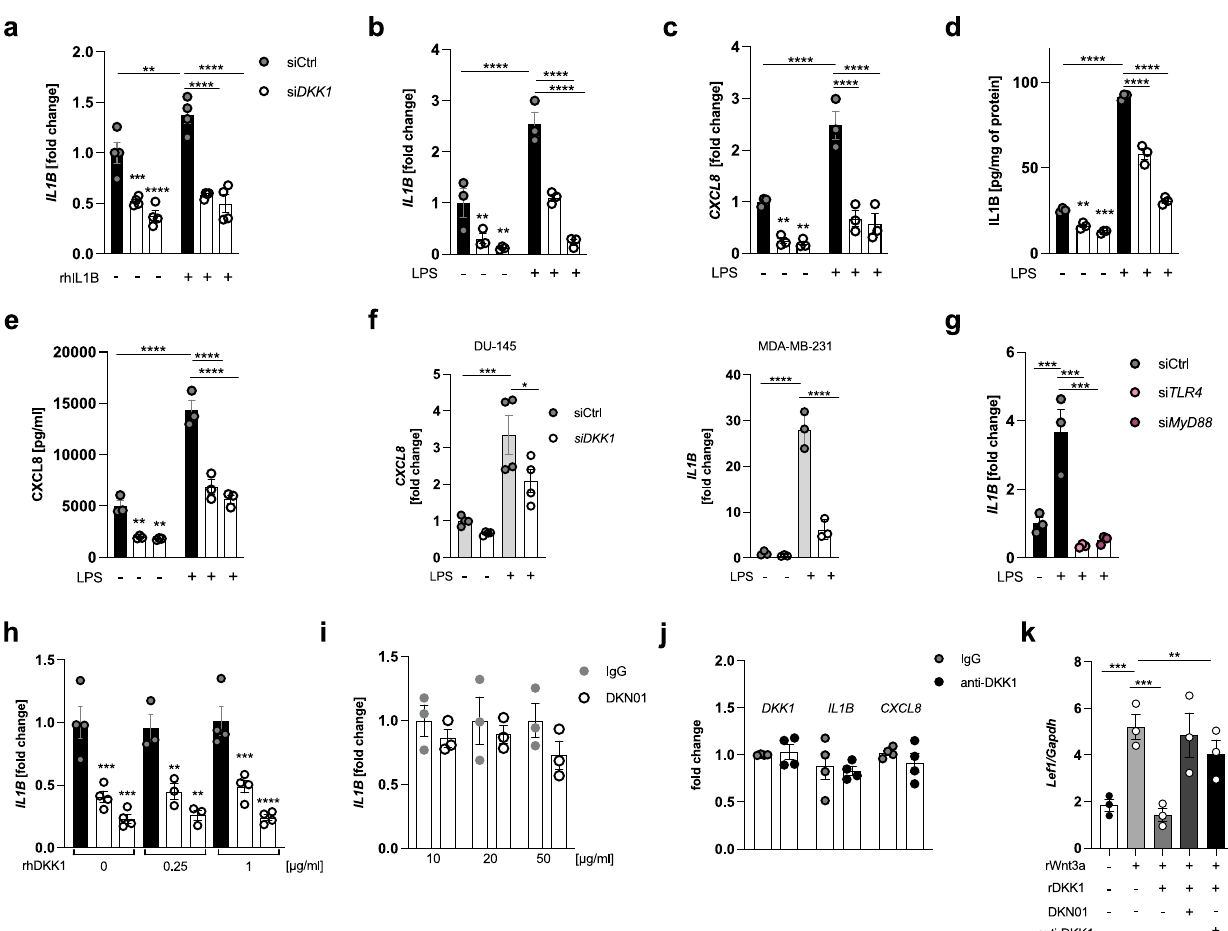
Fig. 3 Cancer cells require DKK1 to mount in fl ammatory cytokine responses. a IL1B transcript levels in DKK1-competent and -de fi cient PC3 cells following 24h exposure to recombinant IL1B (rhIL1B) (20ng/ml) or vehicle (PBS) ( n = 4/group). b , c IL1B and CXCL8 mRNA expression in DKK1-competent